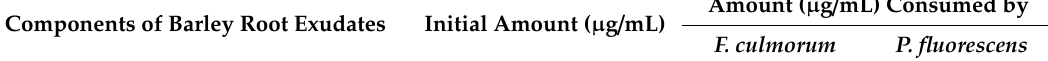
Amount ( µ g / mL) Consumed by F. culmorum P.